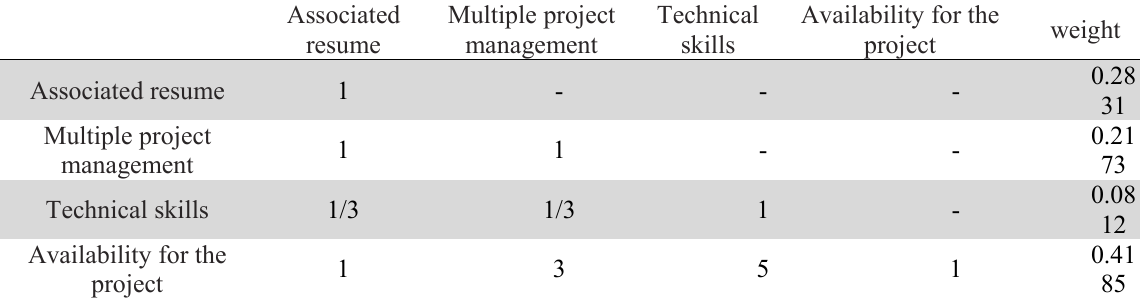
Comparisons in second level, Petroleum project